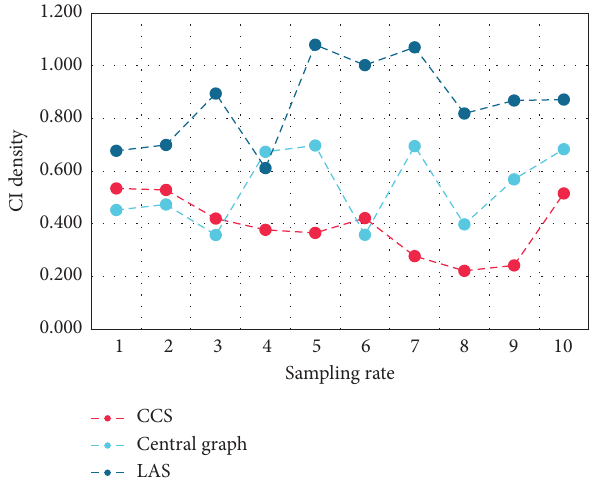
Figure 1: Density CI